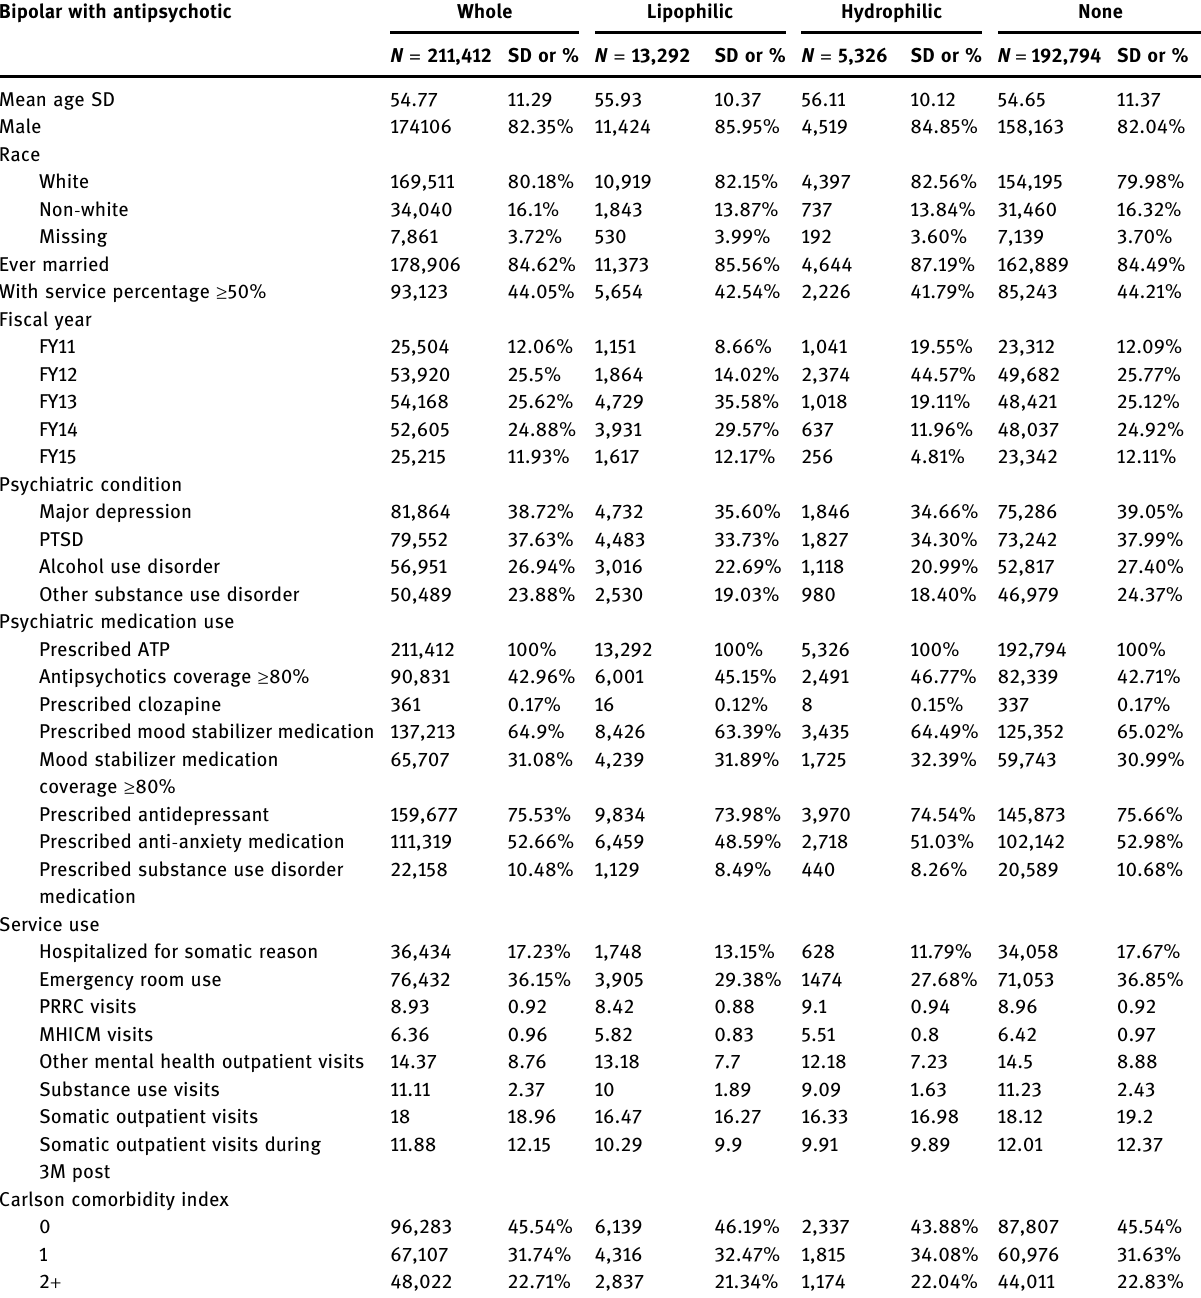
Table 2: Description of individuals with BD on antipsychotic medication Bipolar with antipsychotic Whole